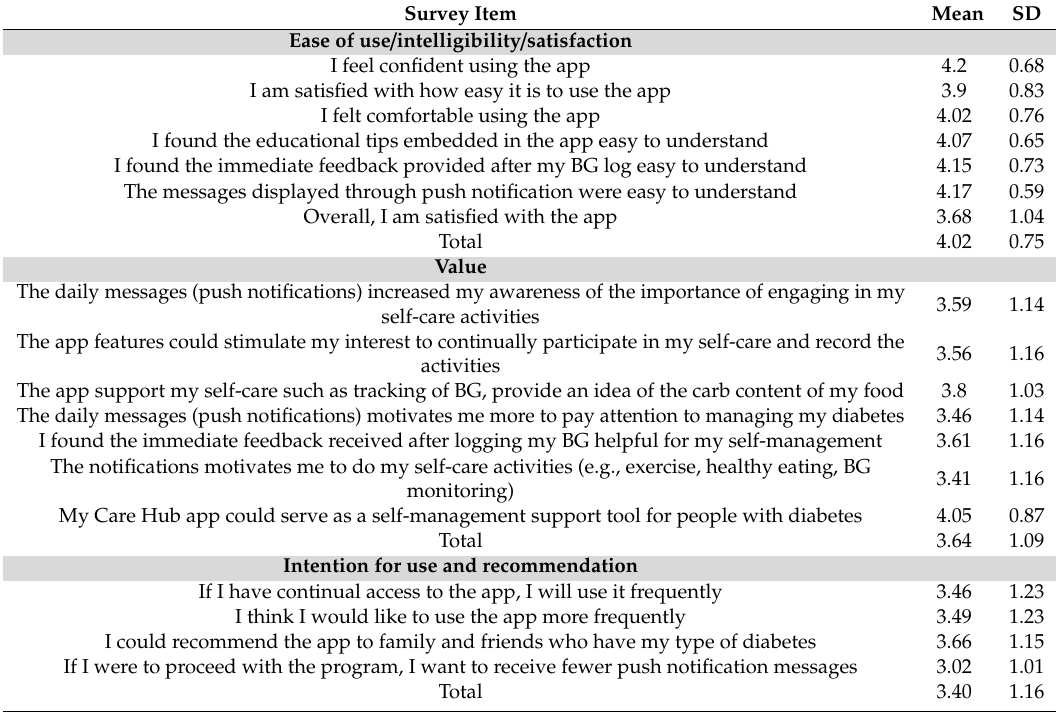
Table 3. Participant acceptability ratings (N =